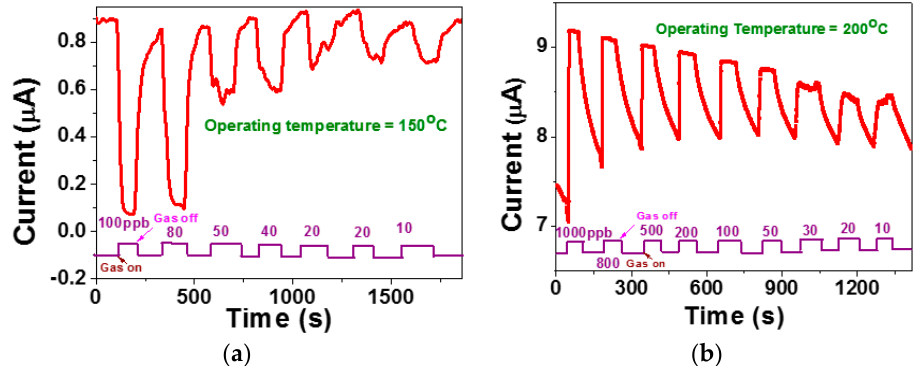
Figure 2. Transient response of devices towards H 2 S ( a ) plasma oxidized and ( b ) sputtered